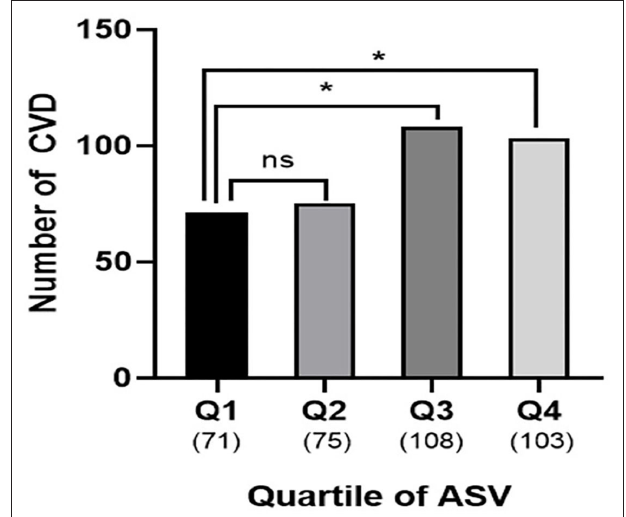
Numbers of patients with CVD were higher in quartile 3 and 4 compared to quartile 1 (Q1, n = 71 vs. Q3, n = 108 vs. Q4, n = 103; P = 0.004). Number in parenthesis represent number of CVD in each quartile. The asterisks denote the significance levels compared with Quartile 1 (control group) using chi-square test followed by post-hoc analyses. * P < 0.05. ns, non-specific; ASV, average successive variability; CVD, cardiovascular disease; Q,